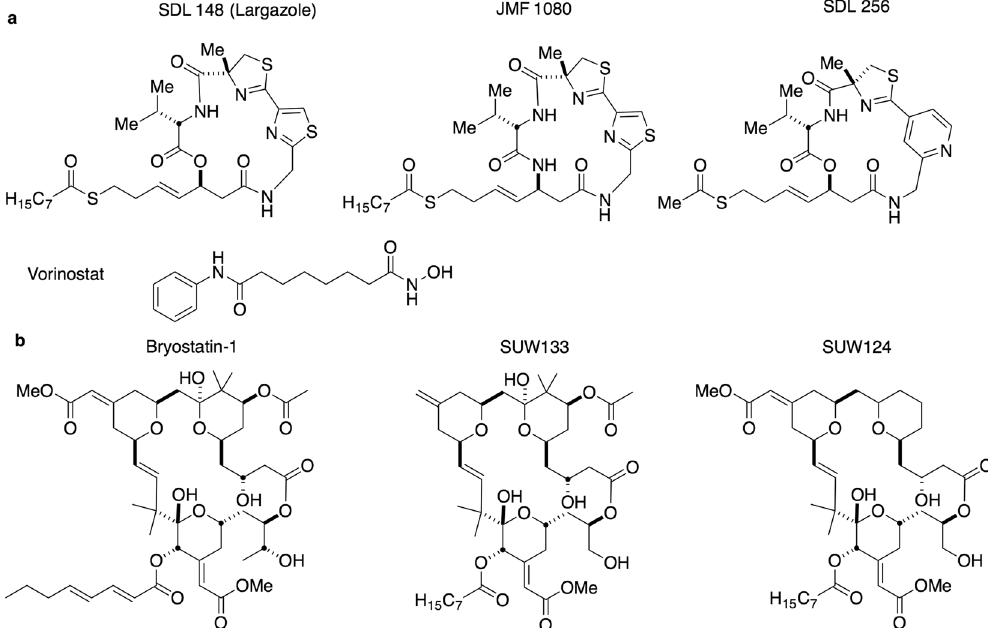
Figure 1. Structures of compounds implemented in LRA screens and HIV reactivation studies herein. ( a ) HDAC inhibitors including SDL148 (largazole), two of its derivatives JMF1080 and SDL256, as well as, vorinostat (SAHA). ( b ) PKC modulators including bryostatin-1 and two of its analogs SUW133 and